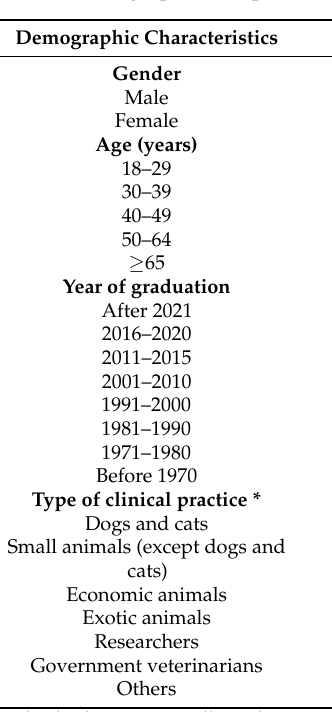
Table 1. Demographic and practice characteristics. ( n =